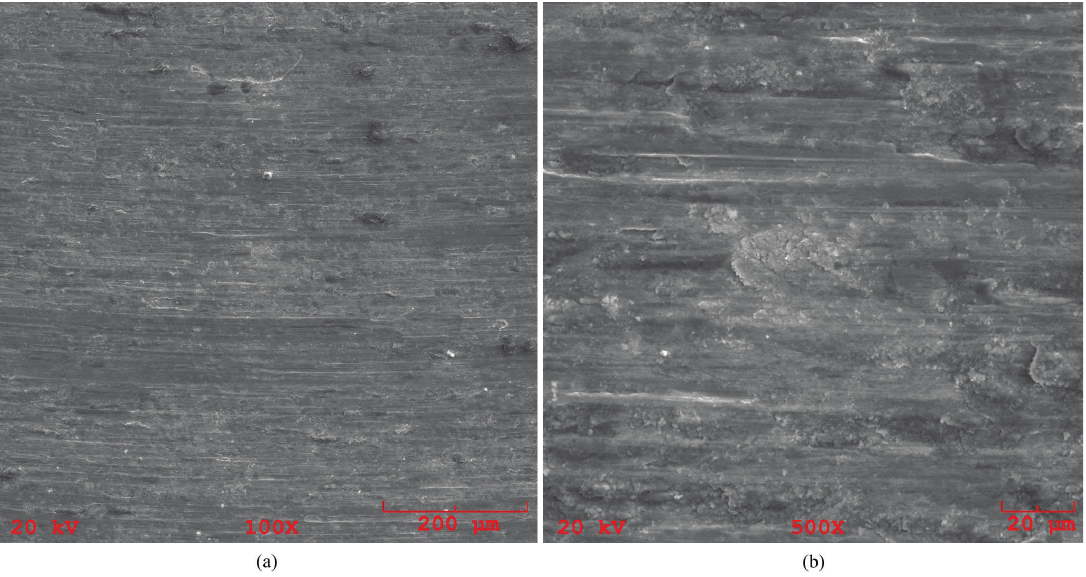
Figure 10. SEM micrographs of wear tracks referring to samples of AISI H13 without treatment: a) 100x and b) 500x.